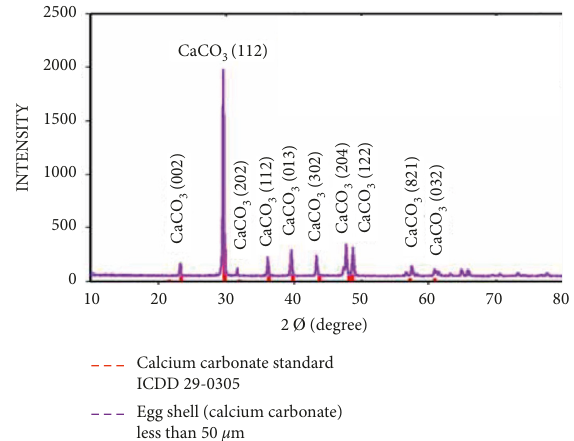
Figure 5: X-ray diffraction patterns for the eggshell with a particle size of less than 50 μ